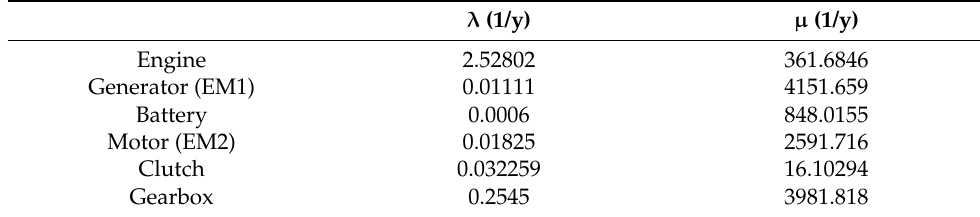
Table 6. Failure and repair rates of involved